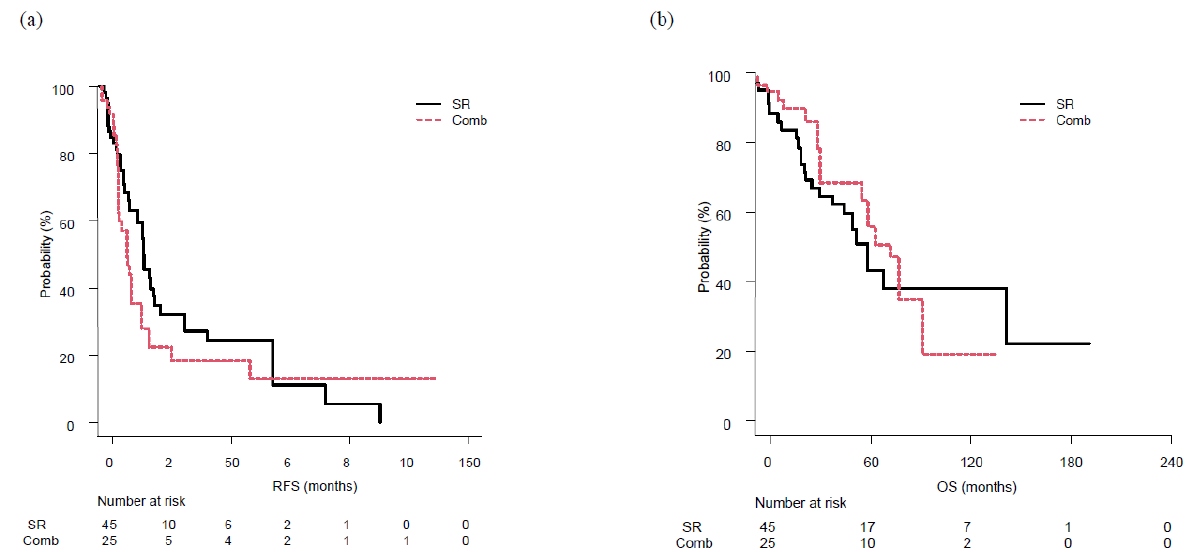
Figure 3. Recurrence-free survival (RFS) and overall survival (OS) following surgical resection (SR) or combined surgical resection and radiofrequency ablation therapy (Comb), following adjustment with inverse probability weighting. ( a ) RFS was similar in both the SR (17.7 months) and Comb (12.7 months) group, with no significant difference ( p = 0.37). ( b ) Similarly, OS was similar in the SR (66.6 months) and Comb (67.5 months) group, with no significant differences ( p = 0.65).